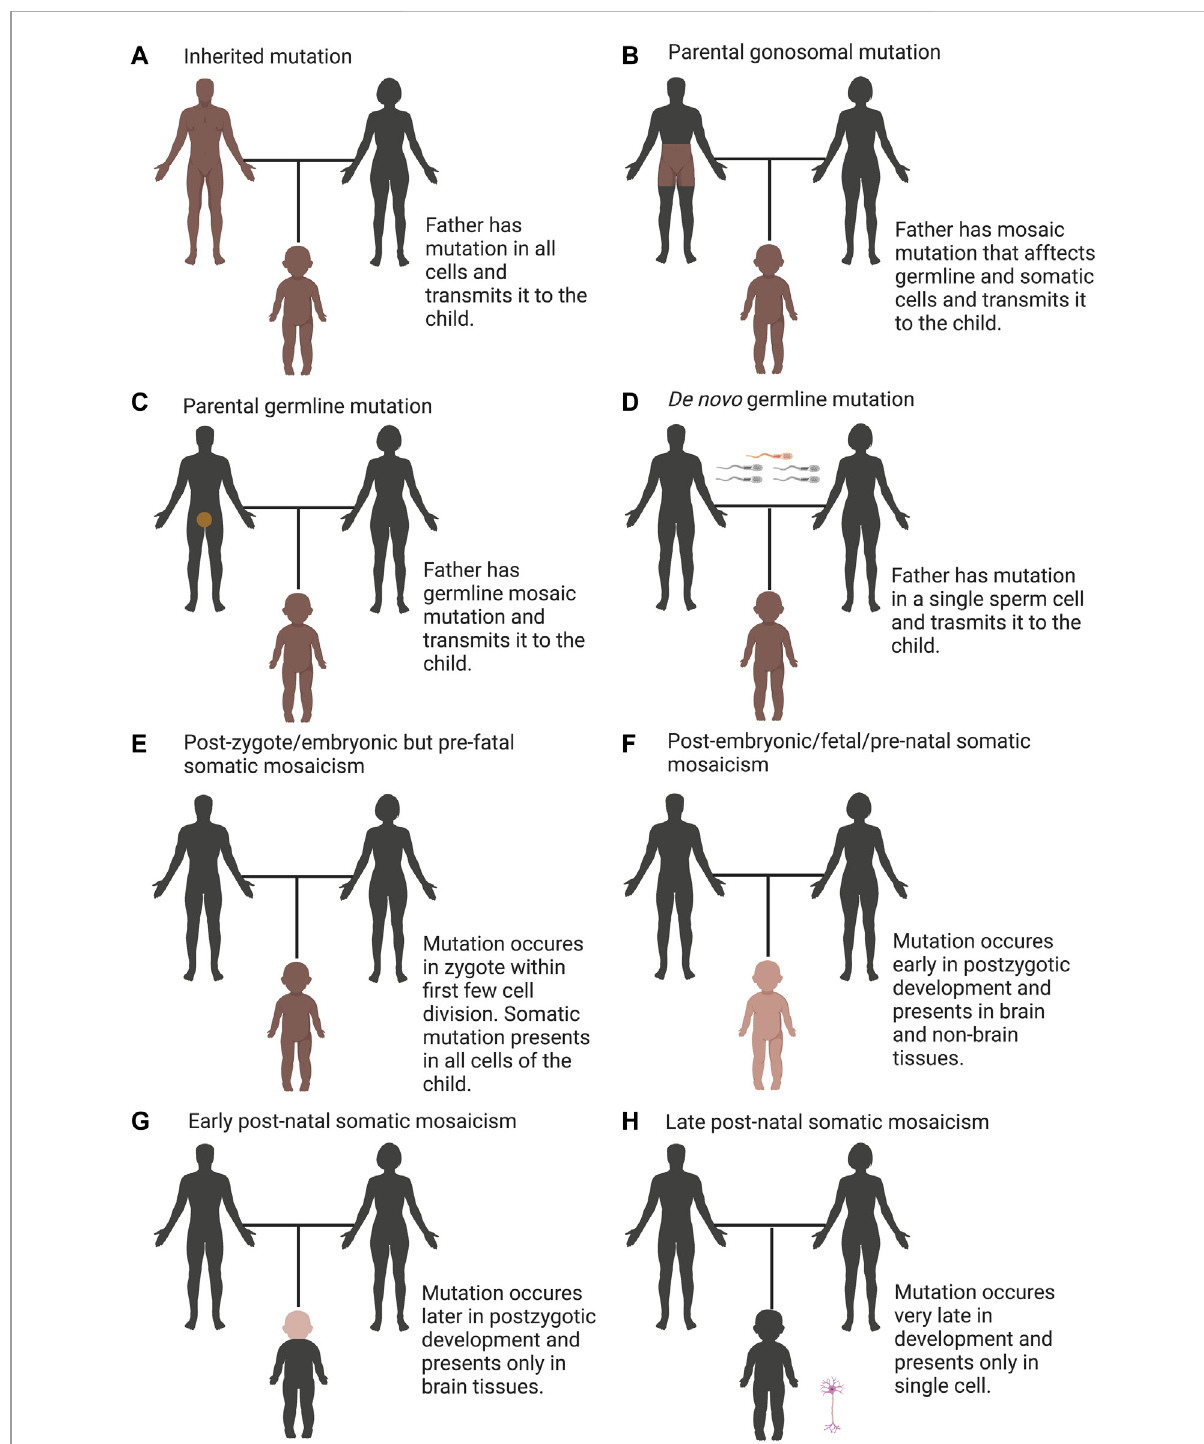
FIGURE 1 Overview of categories of mutations including inherited, de novo , and somatic variation. (A) Inherited mutations are constantly transmitted throughthegermline,whichisdetectableinall tissuesofthechildand theirparent. (B) Parentalgonosomal mutation isdetectableinsometissuesof theparentsandinalltissuesofthechild,whichistransmittedfromaparentwithmosaicmutation(combinationofsomaticandgermlinemosaicism). (C) Parental germline mosaicism is detectable in gametes of the parent and in all tissues of the child. (D) De novo germline mutation is detectable in all tissues of the child but not detectable in the parent. (E) post-zygote/embryonic but pre-fetal somatic mosaicism occurs in zygote within fi rst few cell divisions such that the mutation presents in all cells that contribute to the embryo, is detectable in all tissues of the child but not